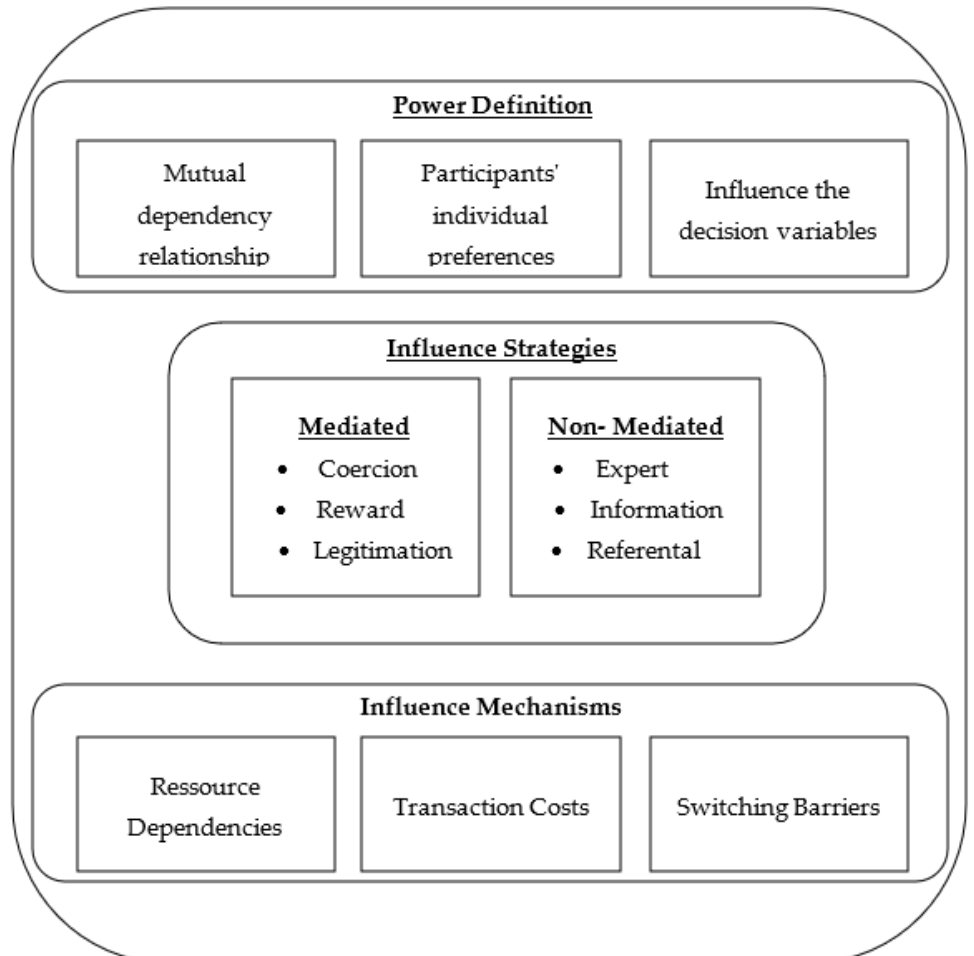
Figure 4. Dimensions of power.